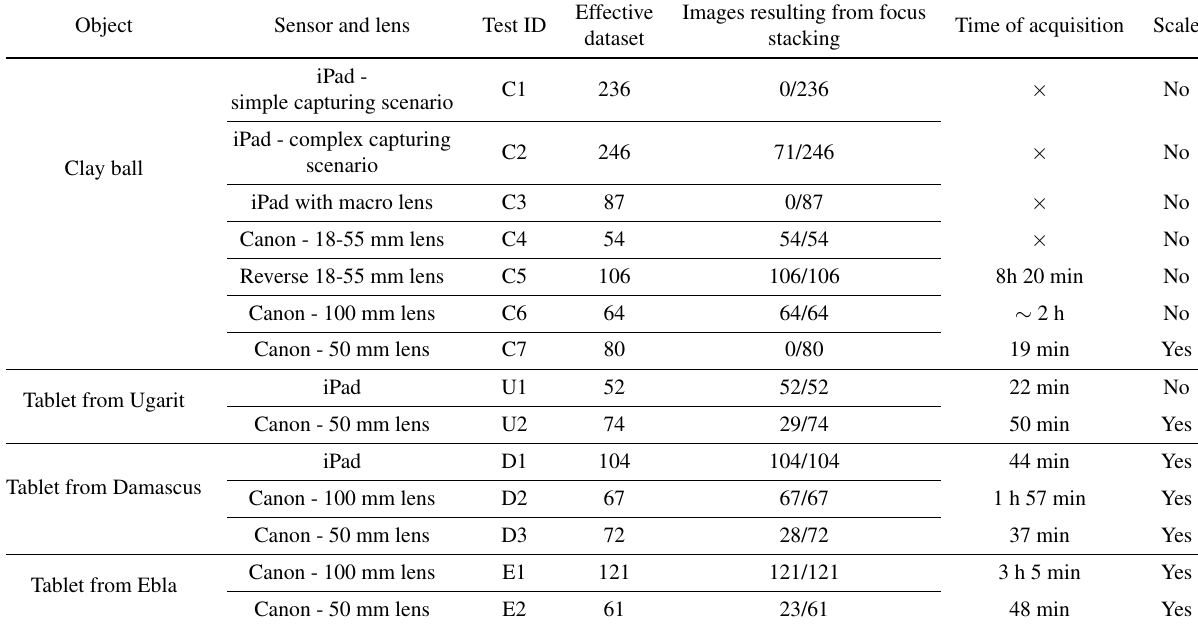
Table 4: Effective dataset, images resulting from focus stacking, acquisition time per test and scale for each test